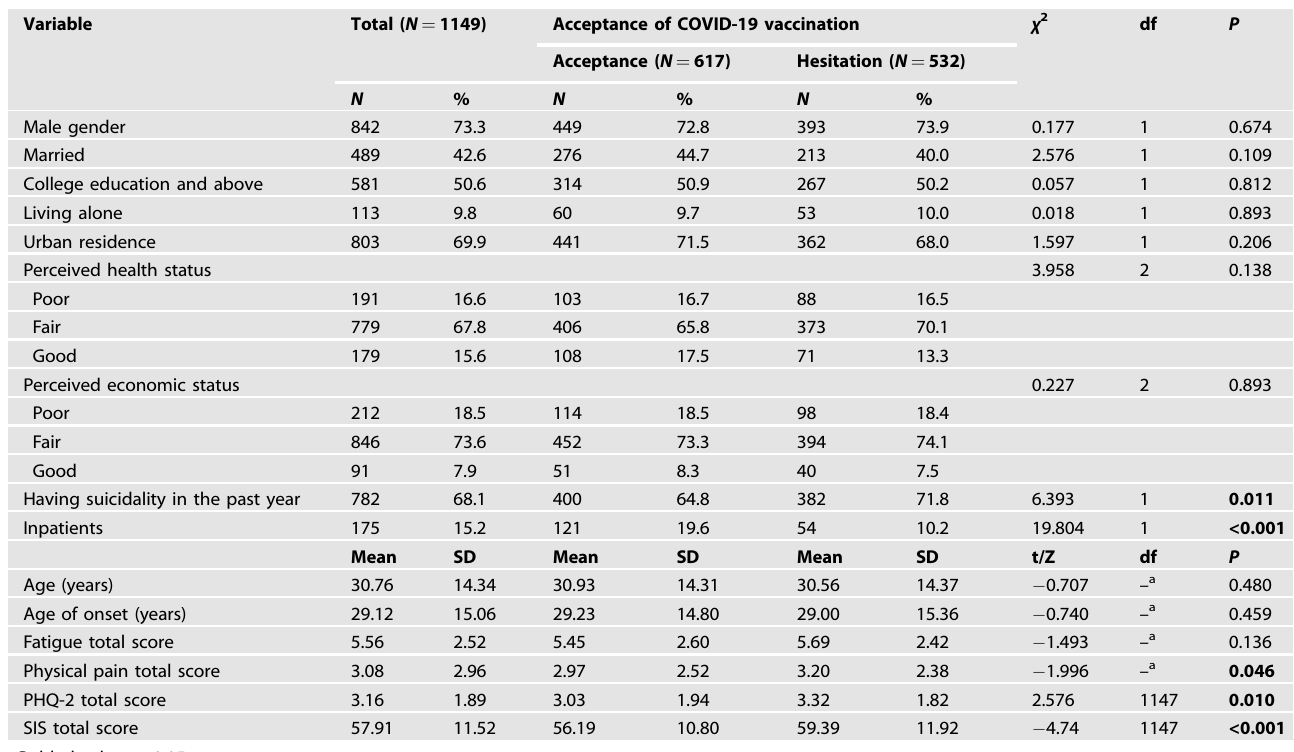
Table 1. Demographic characteristics of participants. Variable